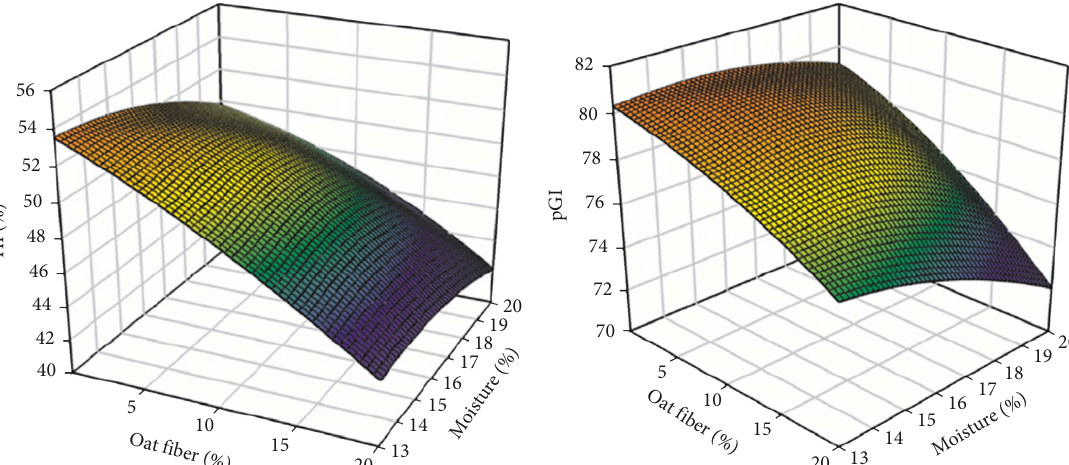
Figure 4: Effects of supplementation with different levels of oat fiber and tempering moisture content (%) on the starch hydrolysis index (HI) and the predicted glycemic index (pGI) of the collets made from oca